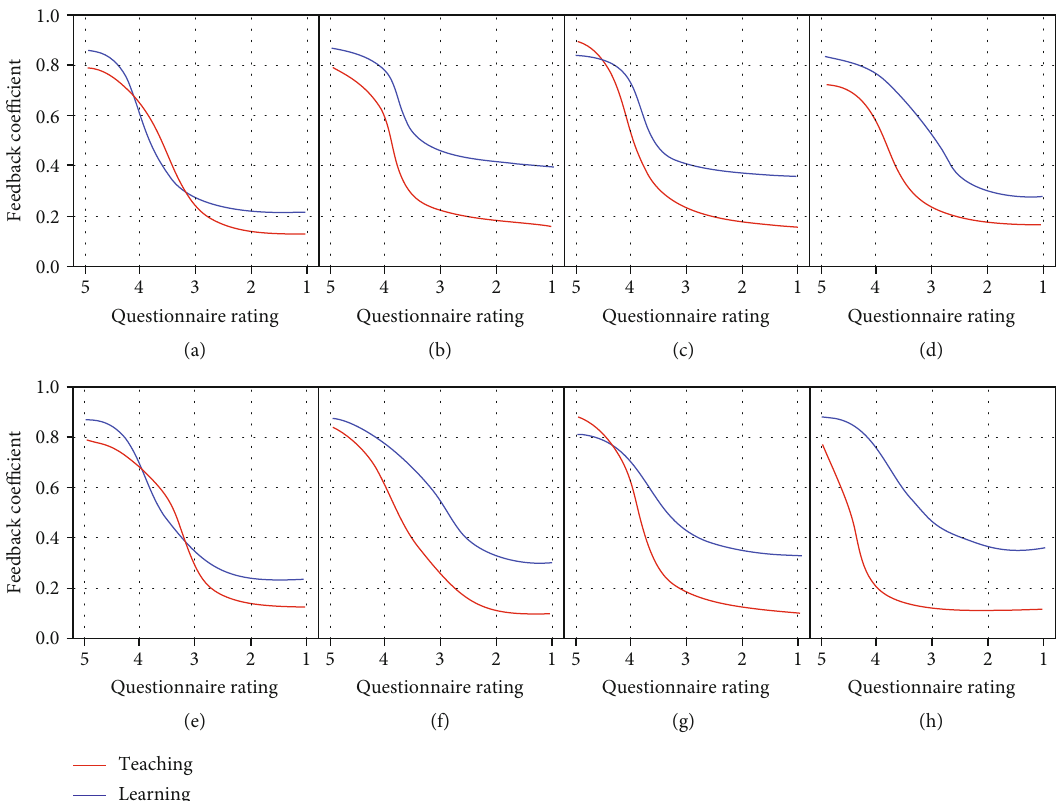
Figure 3: Correlation analysis of AI and role cognition of all 8 (a) – (h) di ff erent categories in the education system. (a) Preschool education, (b) primary education, (c) secondary education, (d) high education, (e) adult education, (f)network education, (g) enterprise education, and (h) social